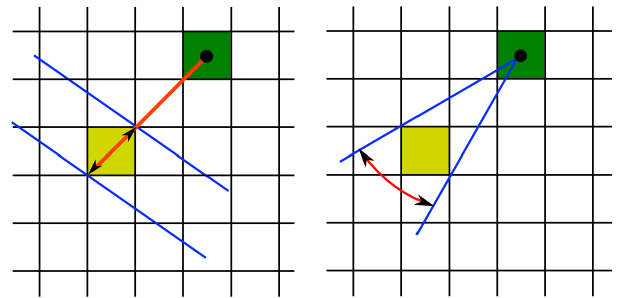
Figure 2. The convolution mask computation. The green grid cell denotes the origin of the mask, and the value for the yellow grid cell is computed using the cumulative distribution function for the normal distribution of the step length or the heading, respectively. The left figure displays the bounds for the step length and the bounds for the heading in the right